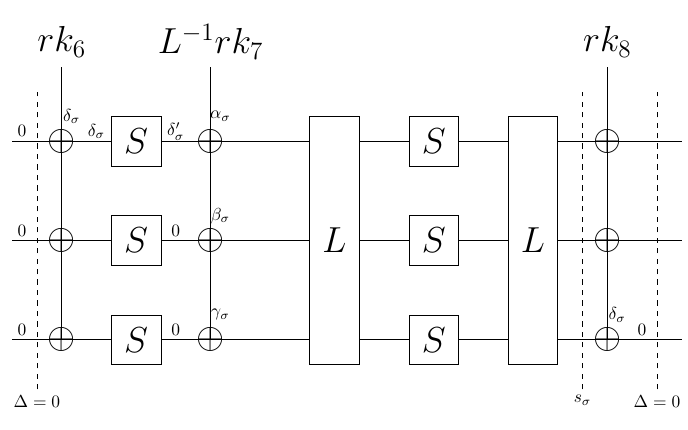
Figure 4: Spontaneous cancellation of